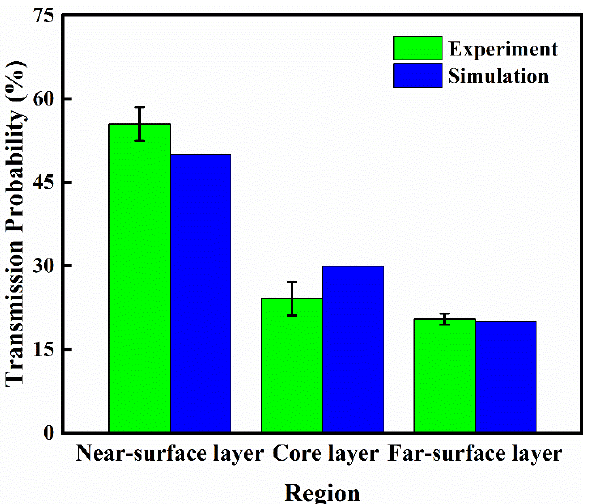
Figure 10. Particle transmission probability of experiment and simulation